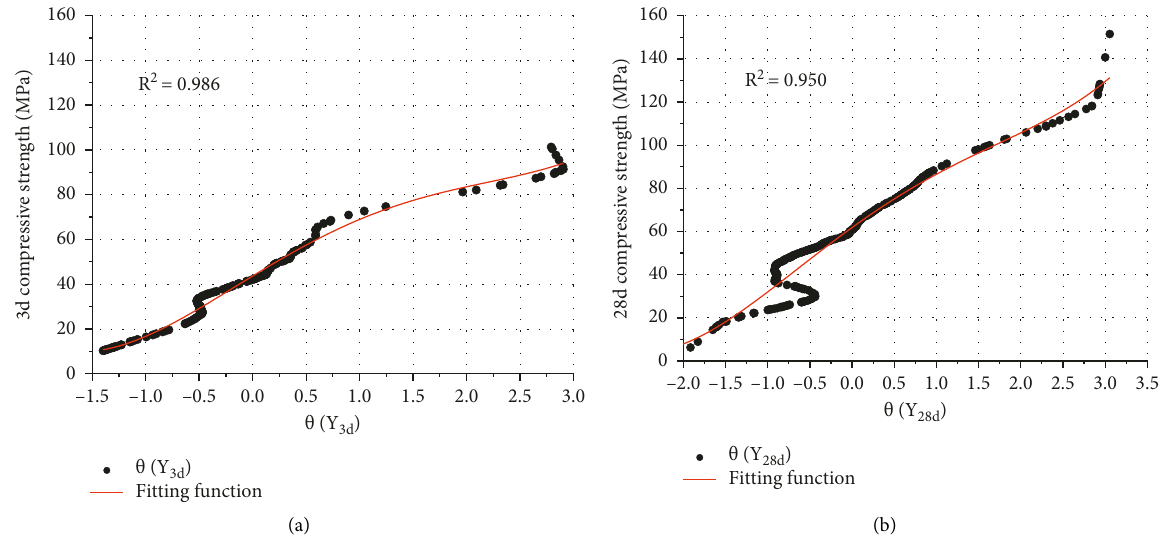
Figure 6: ACE fitting curves of compressive strength of AAS. (a) 3d compressive strength. (b) 28d compressive